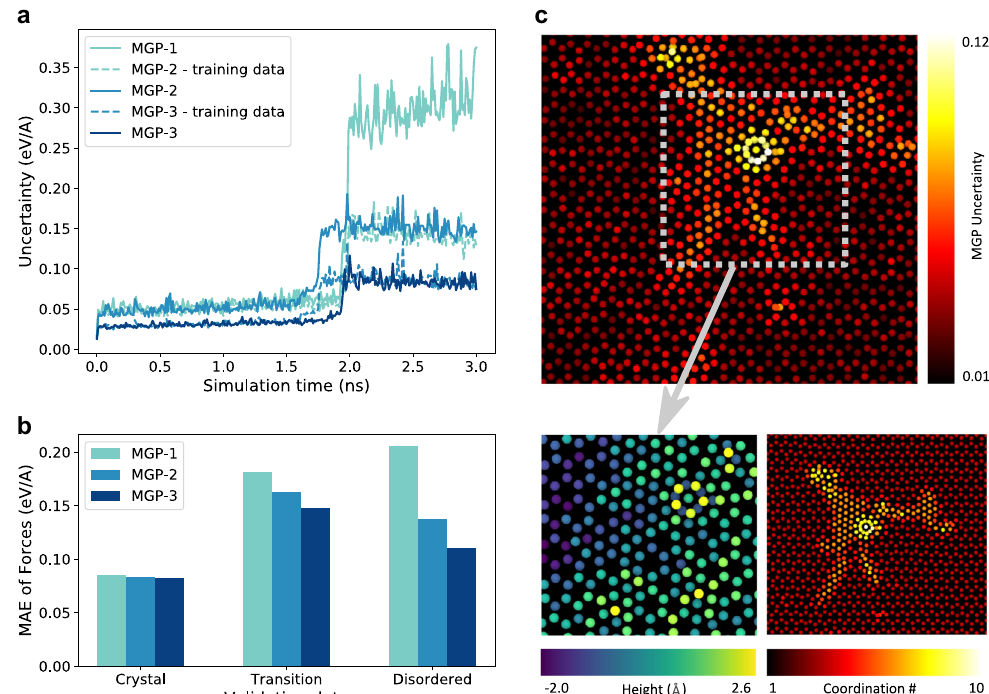
Fig. 3 Uncertainty and accuracy in the Bayesian active learning. a Uncertainty of the force predictions in the whole MD trajectory decreases in three iterations. b Mean absolute errors (MAE) of MGP forces against DFT in three iterations, validated on atomic structures of different phases. c Upper: a snapshot of 2048 atoms from MD simulation at 500 K, colored by MGP uncertainty. The outlined area has highest predicted uncertainty, since it contains a defect and a compact region not known to the fi rst MGP model. Lower-left: zoomed-in structure of the region of high uncertainty, colored by atomic heights ( z -coordinate) to show the bilayer structure of the defect. Lower-right: the same snapshot colored by coordination number, which shows strong correlation with the uncertainty two iterations of training on 200 atoms as MGP-2 and MGP-3. MD are simulated by MGP-1, 2, 3, and the predicted uncertainties of the frames from the three MD trajectories predicted by MGP BFF are shown in Fig. 3a. First, there is a drastic increase of uncertainty